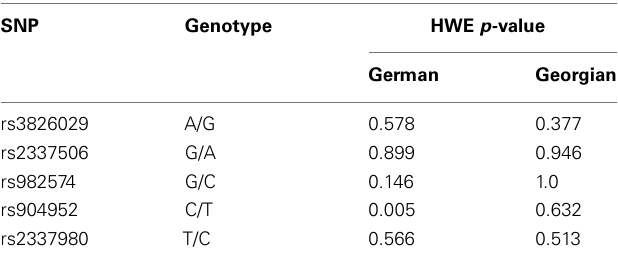
Table 4 | Hardy–Weinberg equilibrium in German and Georgian